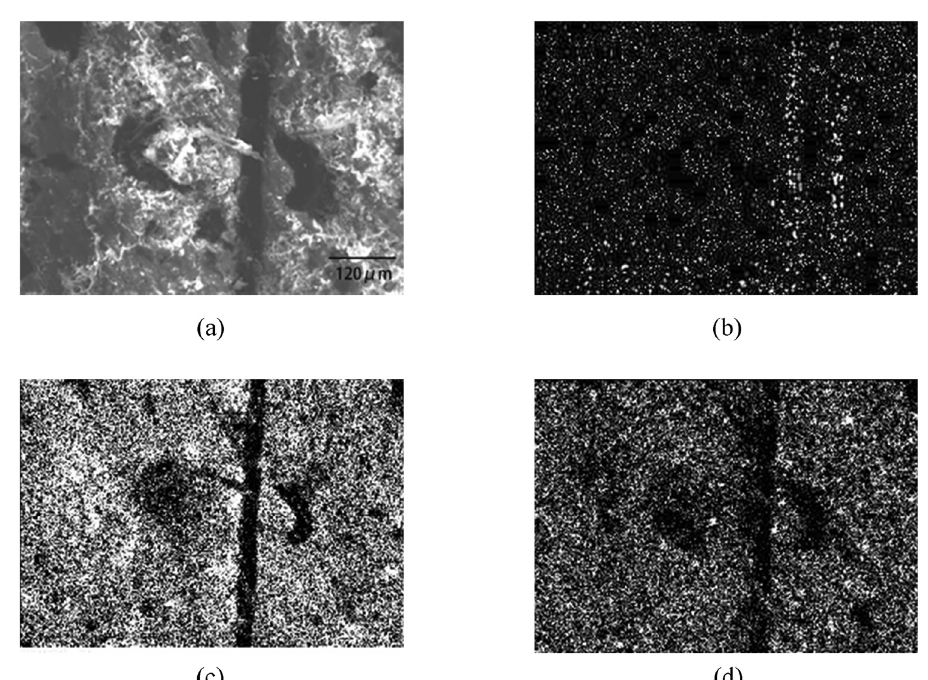
Figure 15: Distribution diagram of the element. ( a ) EDS mapping - scanning of B 4 specimen, ( b ) S K α 1, ( c ) Ca K α 1, and ( d ) Si K α